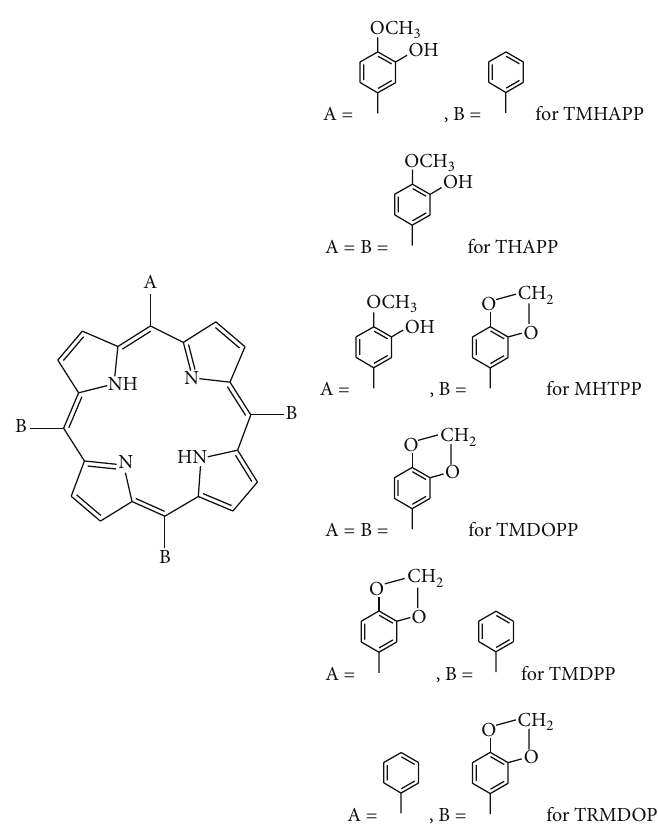
Figure 2: Chemical structures of investigated porphyrins: (1) TMHAPP; (2) THAPP; (3) MHTPP; (4) TMDOPP; (5) TMDPP; and (6)